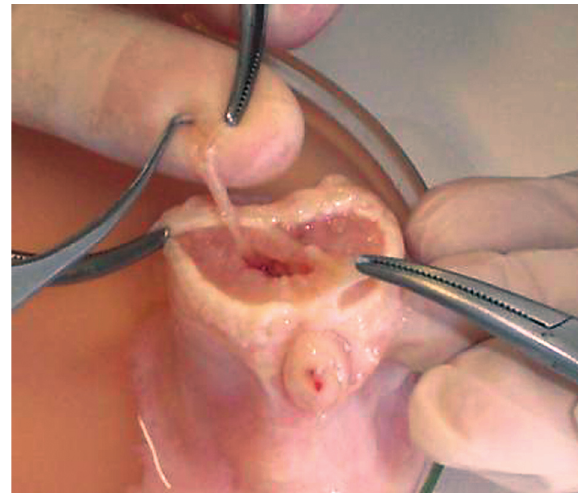
Figure 3 – Cavernous artery.